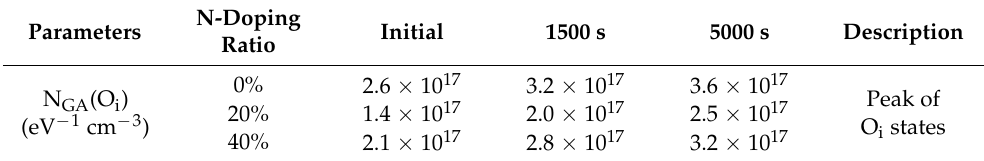
Table 2. Densities of key defect model parameters for a-IGZO TFT fitted with different N-doping ratios after PBS.